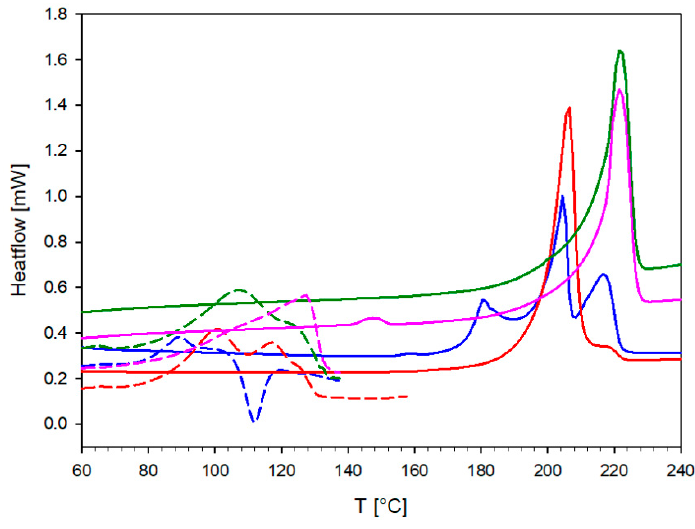
Figure 9. DSC curves of TrCOTyr · MeOH (blue), TrCOTyr · EtOH (red), rac -TrCOTyr · MeOH (green), rac -TrCOTyr · EtOH (pink). The first heating cycle is shown as dashed lines and the second heating cycle is shown as solid lines.